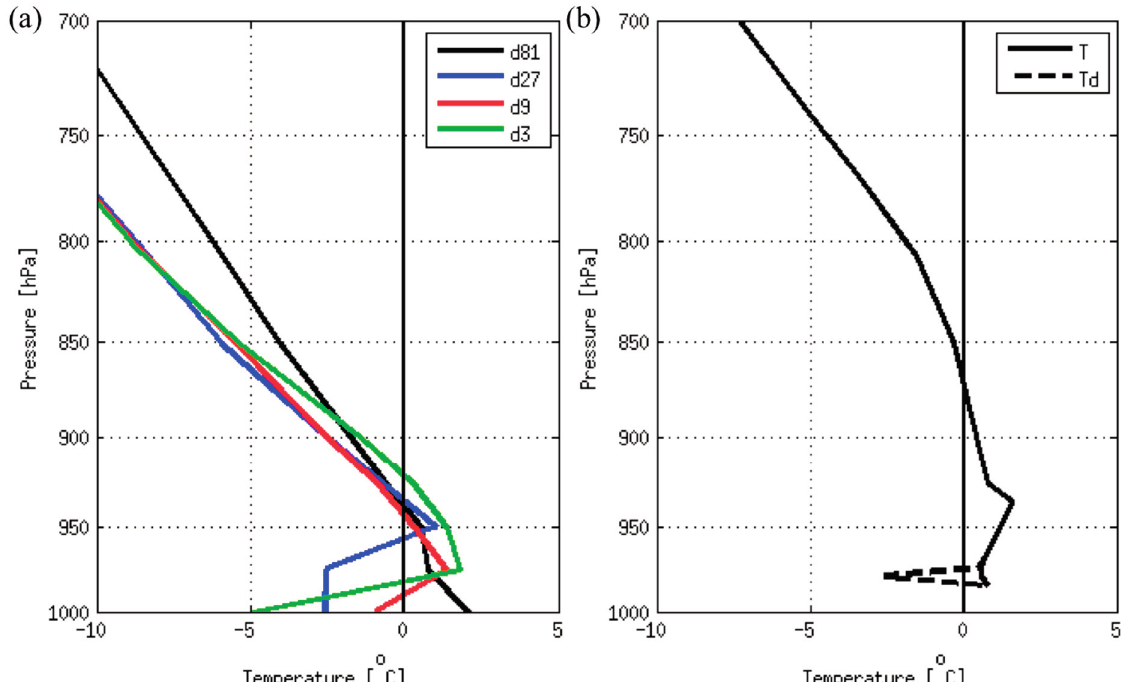
Figure 8. ( a ) Vertical temperature profiles of the d81 (black line), d27 (blue line), d9 (red) and d3 (green line) simulations, for the grid point closest to Québec City (see the blue dot in Figure 1) at 1200 UTC 26 February 2002; ( b ) corresponding observed vertical profile at the closest radio sounding station, Maniwaki, located some 500 km to the west of Québec City (©